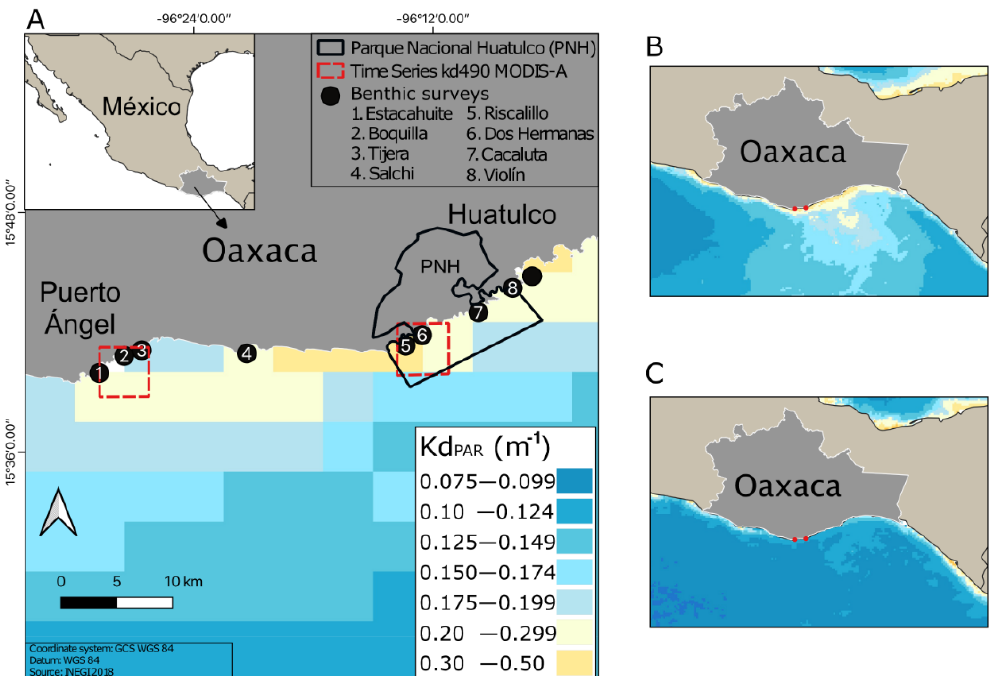
Figure 1. Time average map for the spatial and temporal variability of satellite-derived Kd PAR values of downwelling irradiance in the study area (monthly 4 km resolution; MODIS- Aqua L3m_Kd 490 v2018): ( A ) from November 2019 to October 2021; ( B ) during upwelling season from November 2020 to April 2021; and ( C ) during no upwelling months from May 2021 to October 2021.